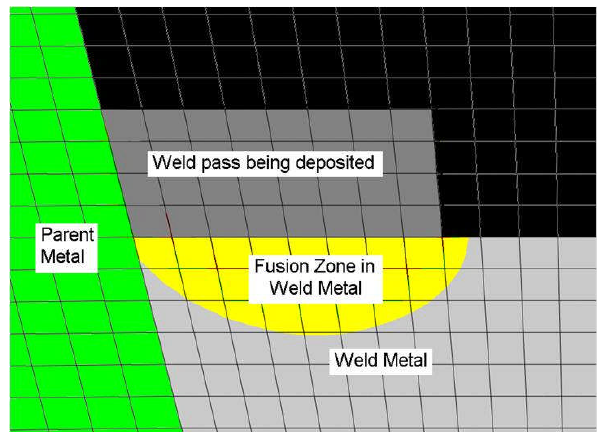
Figure 11. Averaged TC1 & TC2 measurements and FE temperature history.